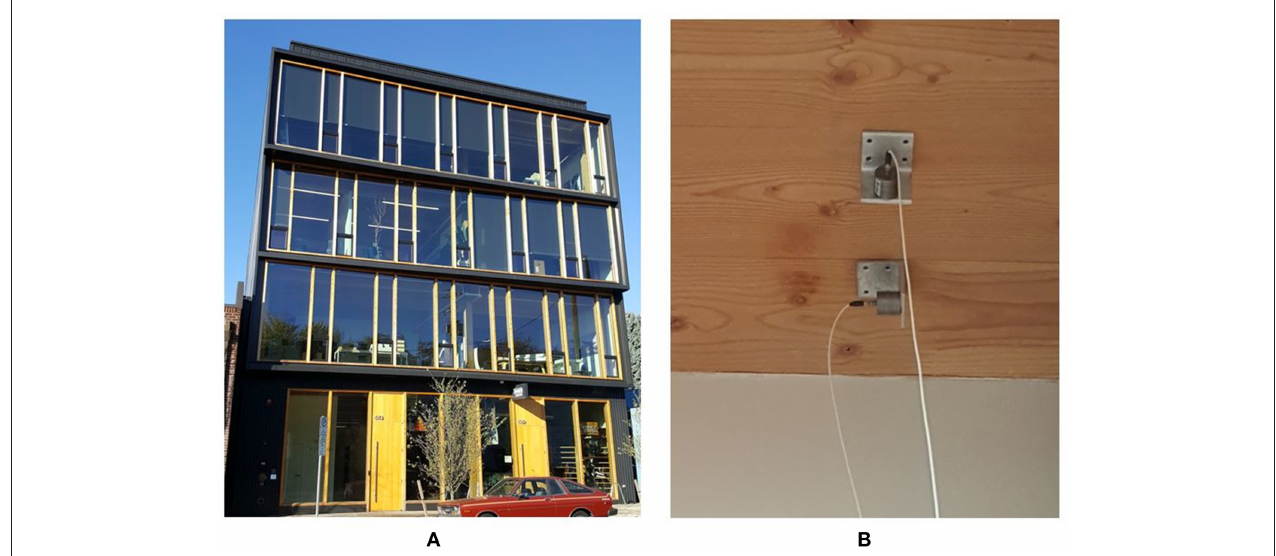
FIGURE 1 | (A) Photo of the “Albina Yard” taken from the East side of the building. (B) Photo showing two uni-axial accelerometers with aluminum-coated brackets attached to the CLT